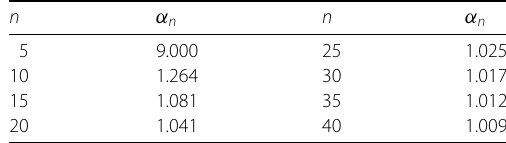
Table 1 Estimates of α n , n = 5 : 5 :